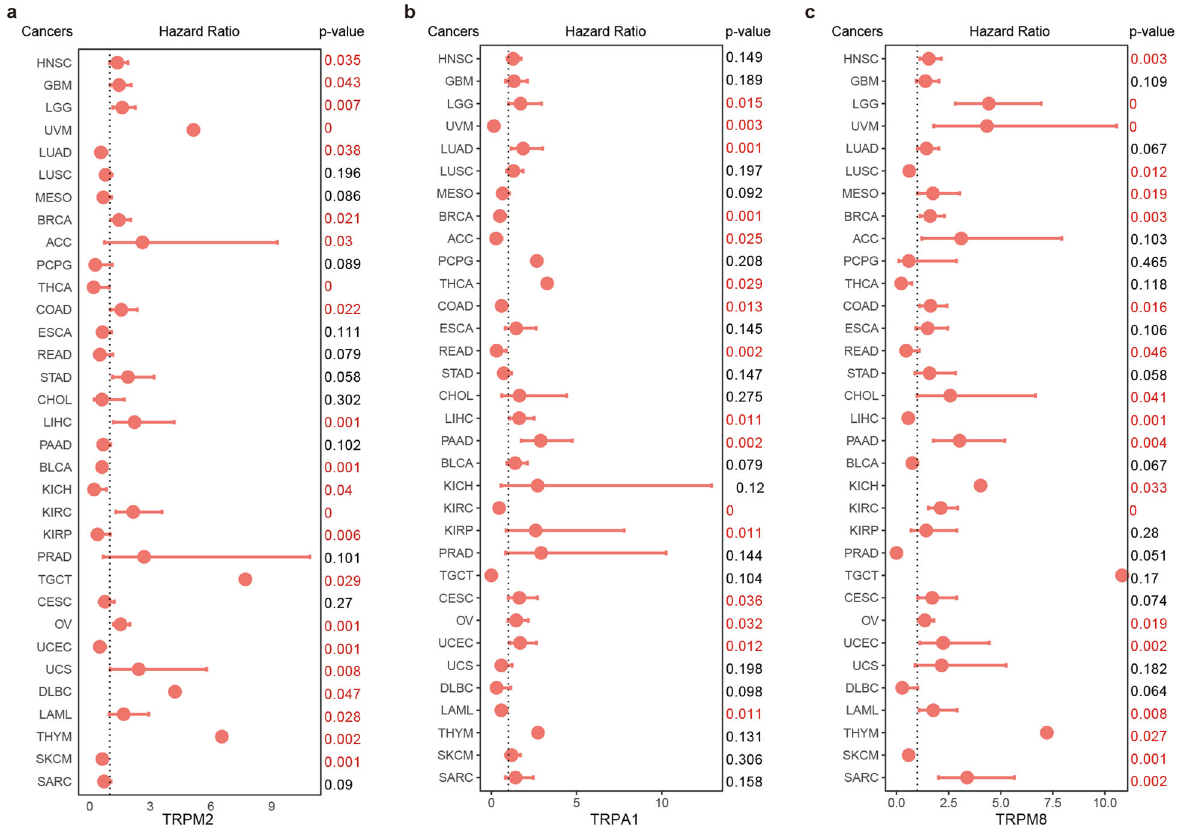
Fig. 5 The distribution of hazard ratios across different cancer types. a The distribution of hazard ratios based on TRPM2 expression across different cancer types. b The distribution of hazard ratios based on TRPA1 expression across different cancer types. c The distribution of hazard ratios based on TRPM8 expression across different cancer types. Centre line of boxplot is the HR, and bounds of box are the 95% con fi dence